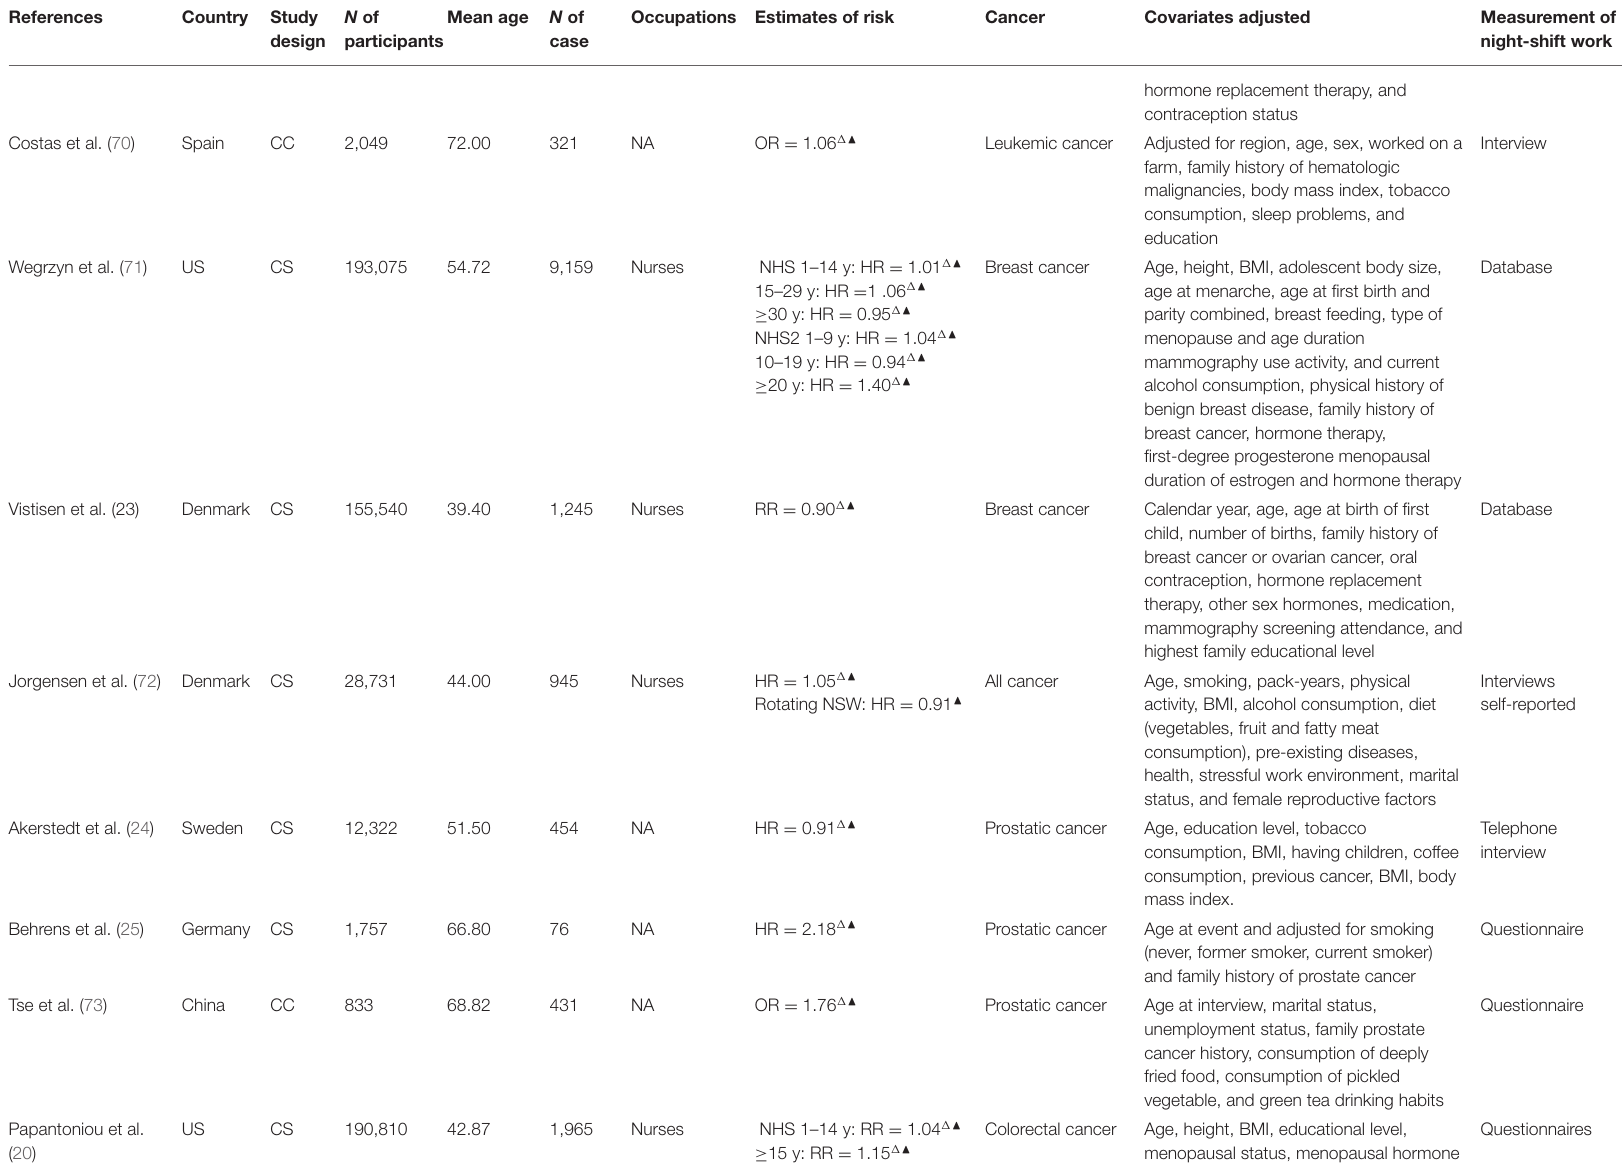
Rotating NSW: HR = 0.91 N